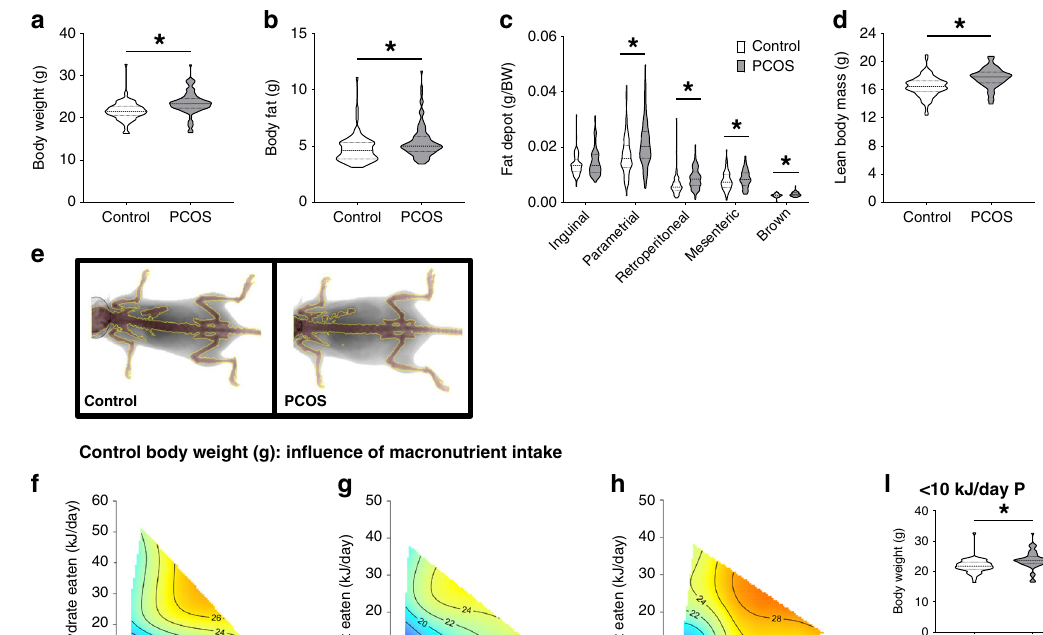
Difference in body weight response between control and PCOS